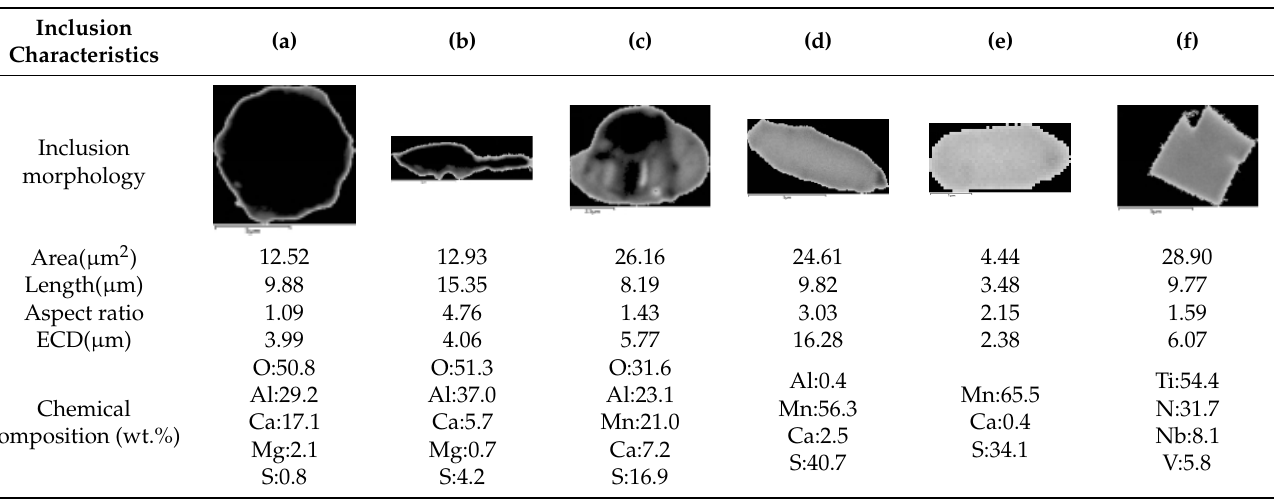
Table 3. Characteristics of typical non-metallic inclusions.